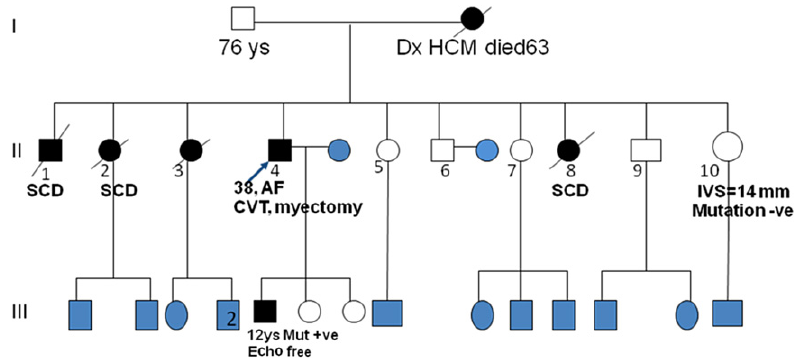
Figure 12. Pedigree of an HCM positive family from the BA HCM Study. A pathogenic mutation in MYH7 exon 23 (Glu927Lys) was detected in the proband II-4. Echo screening of all siblings was undertaken, and sister II-10 was found to have an interventricular septal measurement of 14 mm. Genetic screening of all family members excluded HCM diagnosis for the sister (II-10). However, the symptom free and echo clear son of the